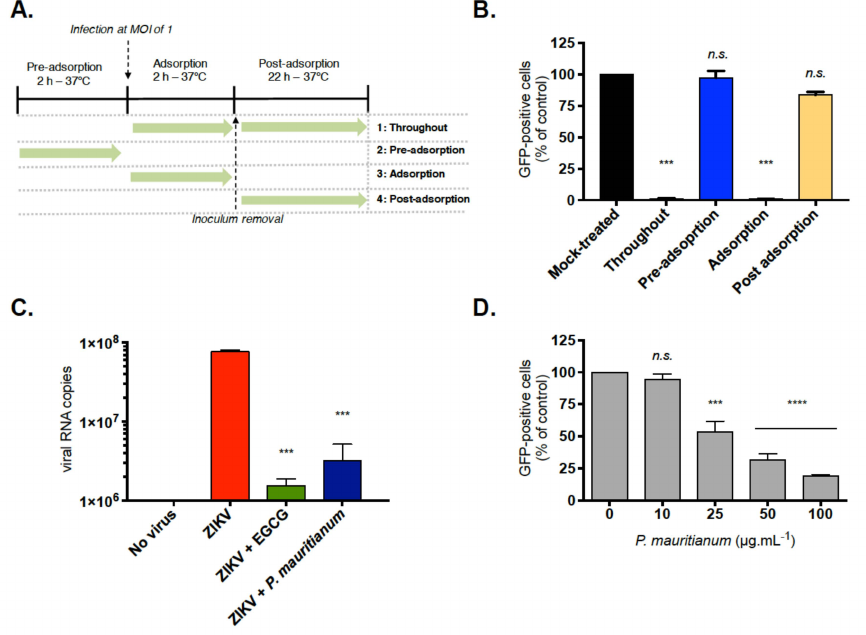
Figure 2. P. mauritianum extract inhibits ZIKV attachment to the cell surface. ( A ) Schematic representation of time-of-drug-addition assays used to characterize the antiviral activity of the P. mauritianum extract (100 µ g mL − 1 ). Green arrow indicates the presence of the plant extract. ( B ) Flow cytometric analysis of GFP expression in Vero cells infected with ZIKV GFP during 24 h at MOI of 1 under the di ff erent experimental conditions shown in ( A ). The results are means ± SD of three independent experiments and are expressed as the relative value compared to untreated infected cells. ( C ) Virus binding assays: Vero cells were infected with ZIKV-MR766 at MOI of 1 for 1 h at 4 ◦ C with or without 100 µ g mL − 1 of the P. mauritianum extract. EGCG (100 µ M) were used as a positive control. The number of virus particles bound to the cell surface was measured by RT-qPCR. The values represent the mean ± SD of three independent experiments. ( D ) Viral inactivation assays: Vero cells were infected with ZIKV GFP pre-incubated during 1 h at 37 ◦ C with four di ff erent concentration of P. mauritianum extract. A flow cytometric analysis of GFP fluorescence was performed 24 hp.i. The results shown are means ± SD of three independent experiments and are expressed as the relative value compared to untreated infected cells. Statistical analyses were performed using a one-way ANOVA and Dunnett’s test for multiple comparisons (*** p < 0.001; **** p < 0.0001; n.s = not